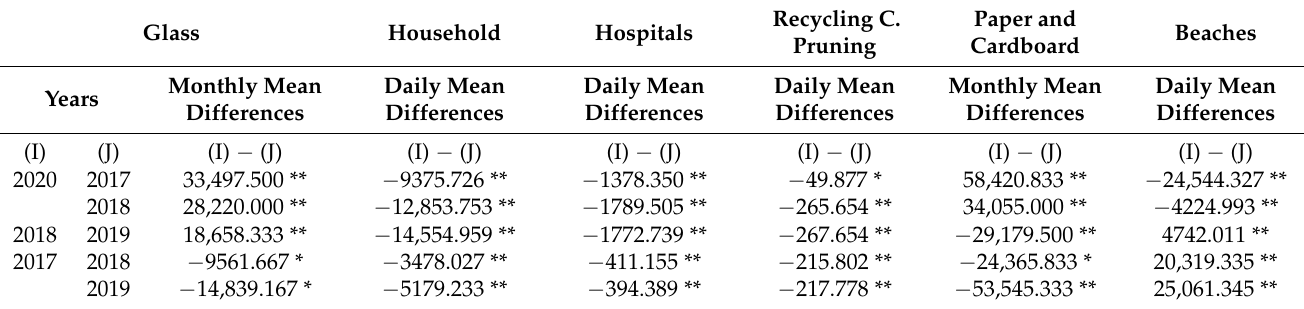
Table 5. Significant differences for glass, household, hospitals, recycling centre pruning, paper and cardboard and beach waste from Bonferroni’s comparison